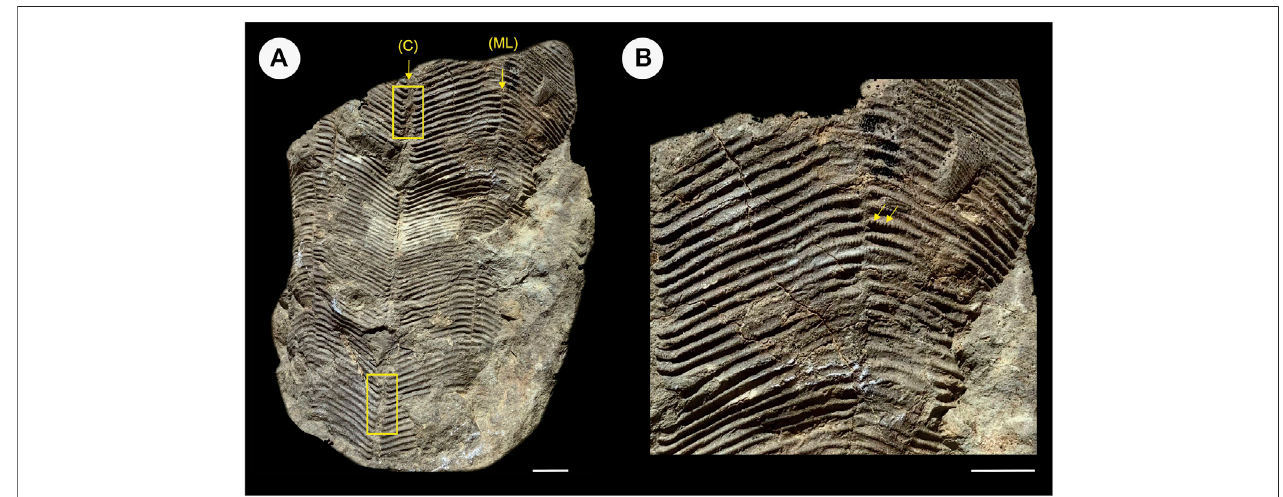
FIGURE 3 | Paraconularia sp. (Mississippian, Kentucky, United States; GP-1E 11672). (A) compressed partial specimen displaying two faces and the corner sulcus between them (photograph oriented with the apertural end of the fossil at the top). Yellow open rectangles highlight stretches of the corner sulcus (C) in which adapertural bending and alternation of the ends of the transverse ribs, which alternate as well along the facial midline (ML), are best displayed. (B) detail of the right face just below the apertural end of the fossil. Yellow arrows immediately to the right of the facial midline highlight some of the minute nodes. Scale bar: 10 mm.